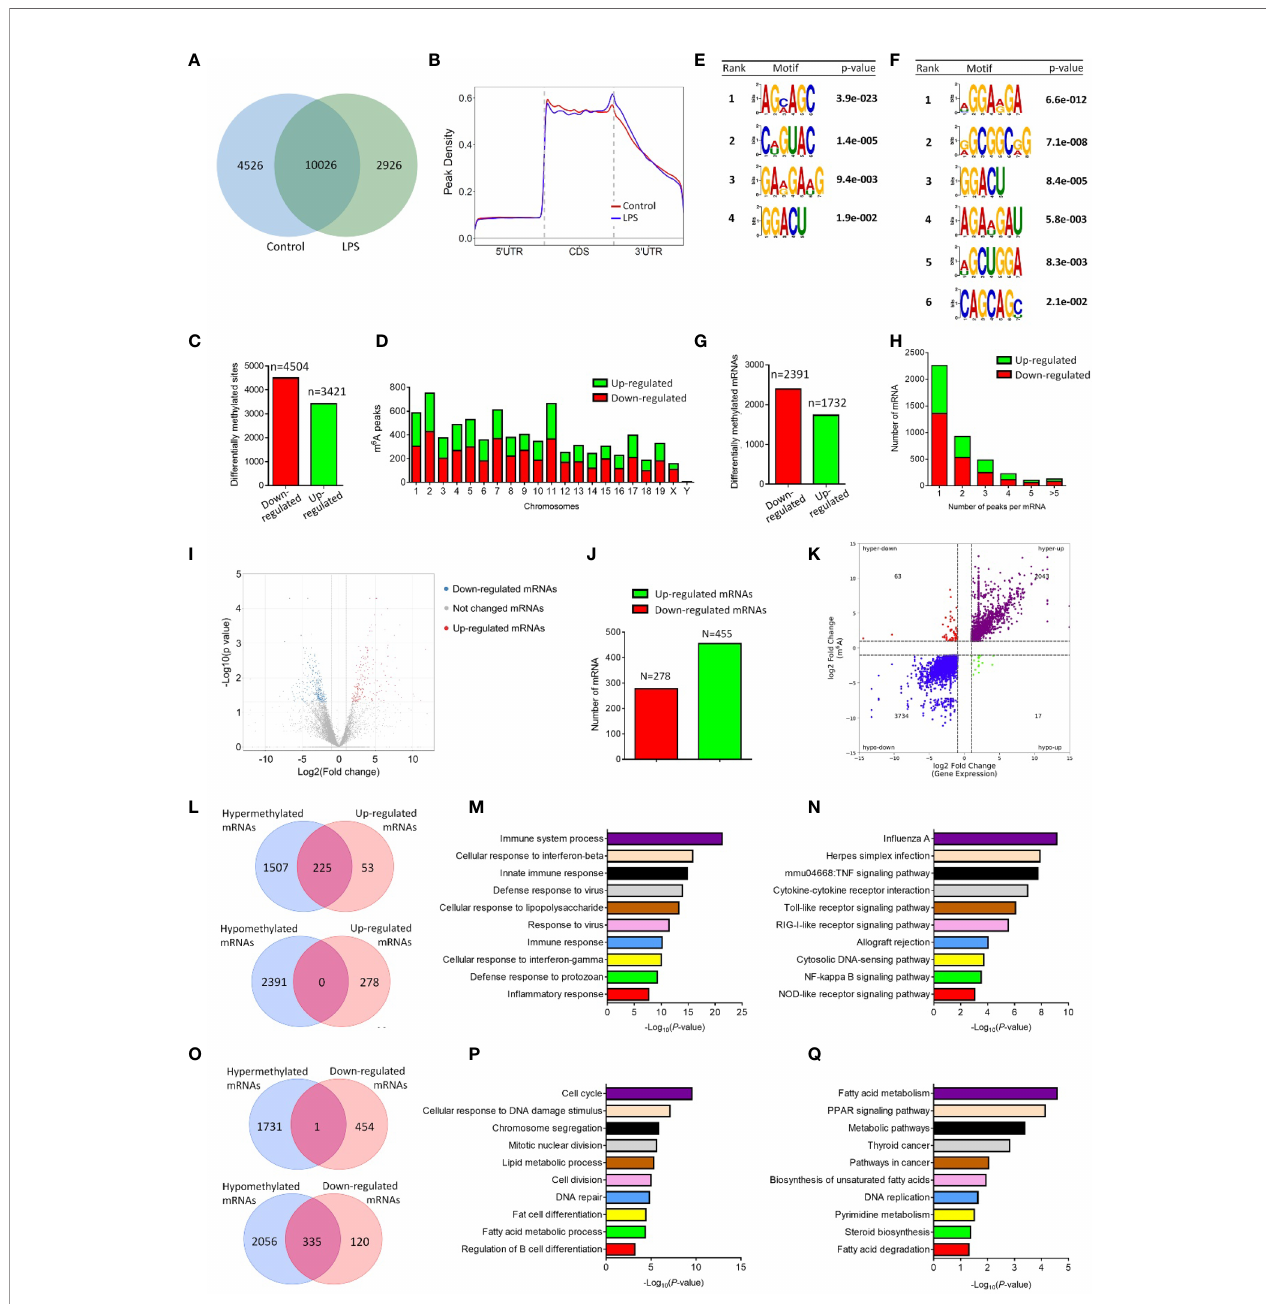
FIGURE 1 | LPS stimulation alters the m6A modi fi cation patterns of primary microglia. (A) Venn diagram showing the detected m6A peaks in control and LPS- stimulated microglia. (B) Accumulation of the region of average m6A peaks along all transcripts in control and LPS-stimulated microglia. (C) The numbers of signi fi cantly altered m6A peaks after LPS treatment. (D) The distributions of altered m6A peaks in human chromosomes. (E, F) The m6A motifs enriched from the detected m6A peaks in control (E) and LPS-stimulated microglia (F) . (G) The numbers of mRNAs with signi fi cantly altered m6A peaks after LPS treatment. (H) The distribution of altered m6A peaks per mRNA. (I) Volcano plots showing the differentially expressed genes in microglia post LPS-stimulation. (J) The numbers of differentially expressed genes in microglia post LPS-stimulation. (K) Four-quadrant plots showing the distribution of genes with altered m6A modi fi cation and mRNA levels. (L) Venn diagrams for genes with either up-regulated expression and m6A hypermethylation (upper panel) or up-regulated expression and m6A hypomethylation (lower panel). (M) The top 10 GO terms of genes with m6A hypermethylation and up-regulated expression. (N) The top 10 KEGG pathways of genes with m6A hypermethylation and up-regulated expression. (O) Venn diagrams for genes with either down-regulated expression and m6A hypermethylation (upper panel) or down-regulated expression and m6A hypomethylation (lower panel). (P) The top 10 GO terms of genes with m6A hypomethylation and down-regulated expression. (Q) The top 10 KEGG pathways of genes with m6A hypomethylation and down-regulated